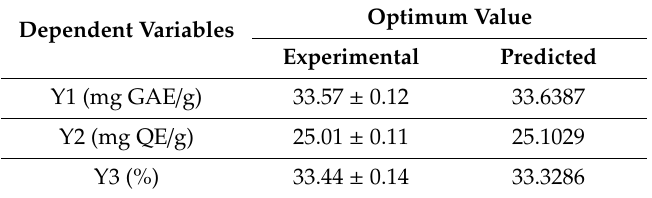
Table 6. Predicted response values and experimental response values obtained at optimum